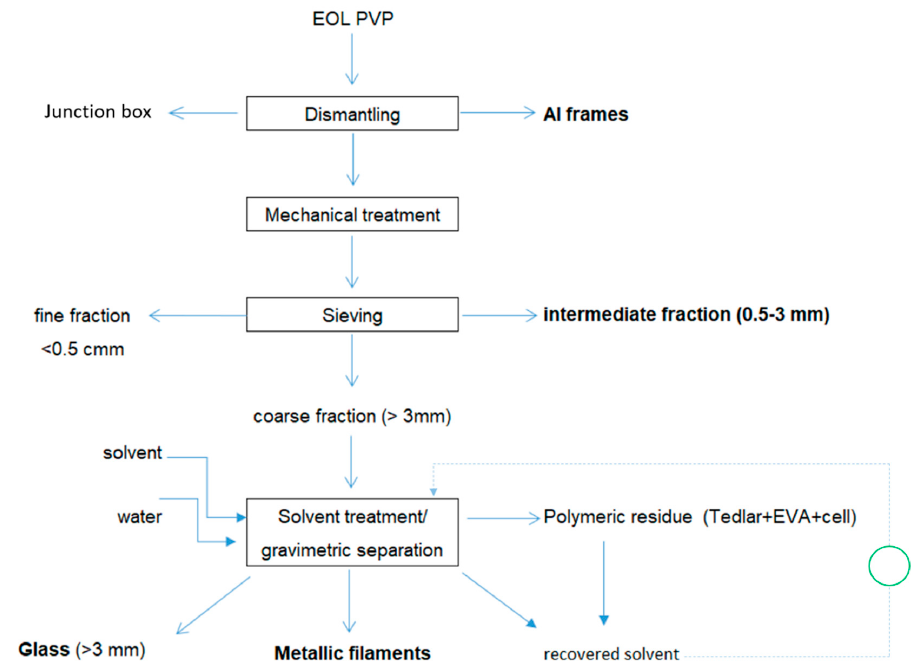
Figure 3. Block diagram of the PhotoLife process: EOL PVP were manually dismantled for removing junction boxes and Al frames; panels were crushed and sieved; coarse fraction was treated by solvent and a gravimetric separation was performed to separate glass and metallic filaments from polymeric residue.